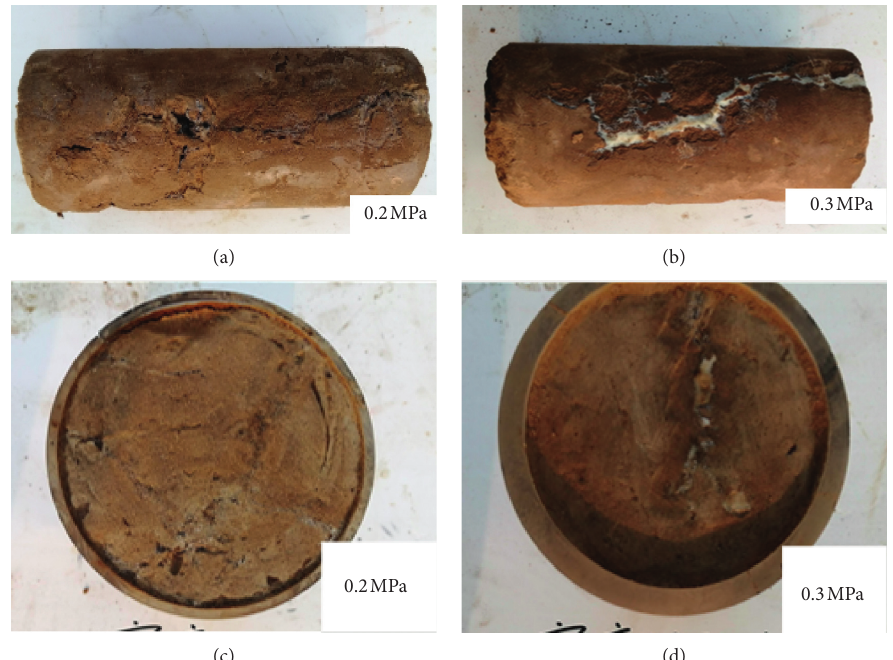
Figure 9: Soil consolidation morphology under different grouting pressure. (a) Profile 0.2 MPa. (b) Profile 0.3 MPa. (c) Bottom 0.2 MPa. (d) Bottom 0.3 MPa.